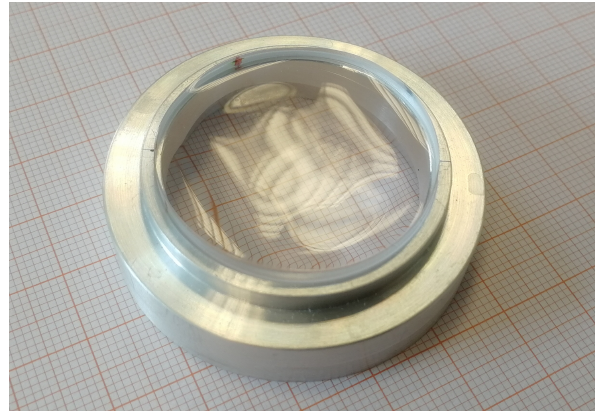
Figure 10. Image of polynomial freeform SUT manufactured using atmospheric plasma jet